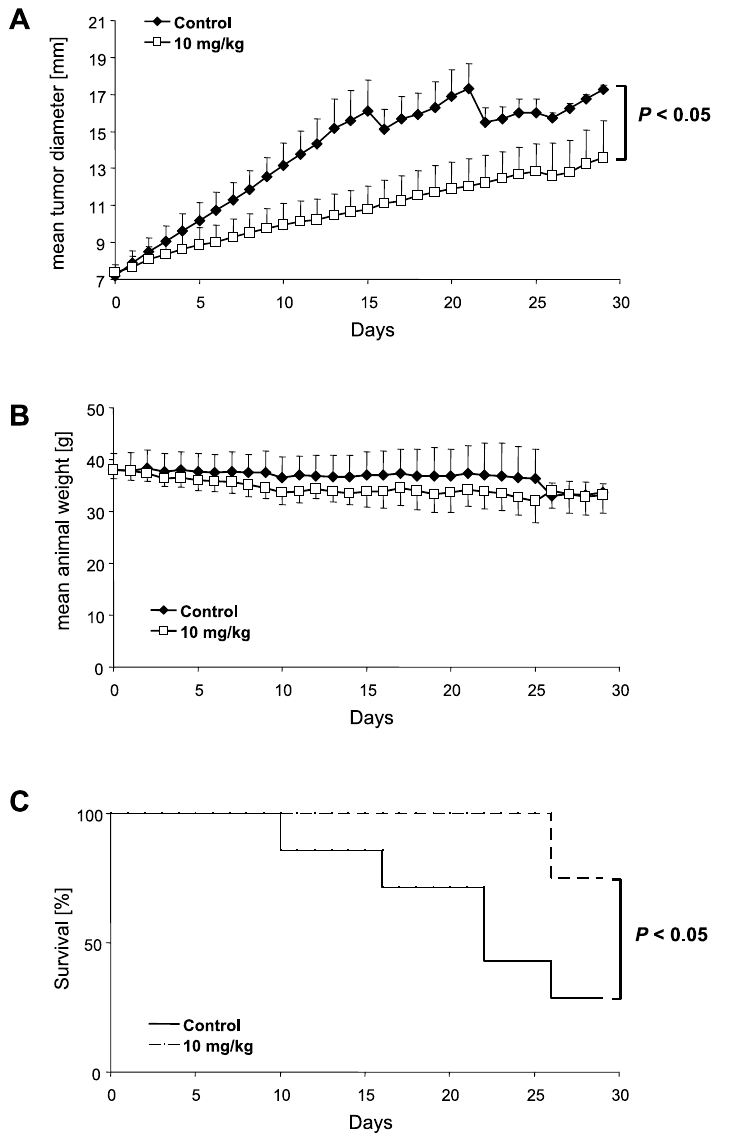
Fig. 5. Panobinostat for treatment of HepG2 xenografts in nude mice. Animals were treated with daily i.p. injections of 10 mg/kg panobinostat or vehicle control. Mean tumor size (A) and animal weight (B) ± SEM of 8 animals/group. (C) Survival analysis of 8 animals/group. All surviving animals were censored on day 30 due to animal protection rules. Mean tumor size in the control group is reduced at days 16 and 22 due to the removal of animals with a tumor diameter of more than 25 mm with respect to animal welfare